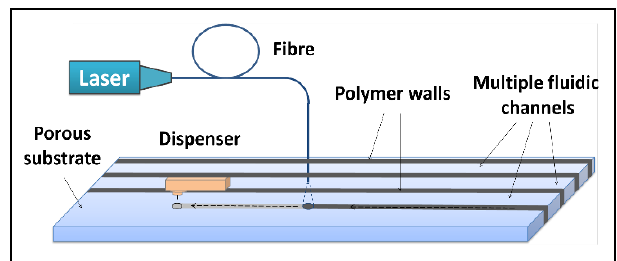
Figure 2. Schematic of the laser-based direct-write setup which shows the local deposition of photo-polymer that is subsequently illuminated by exposure from a 405nm c.w. laser.